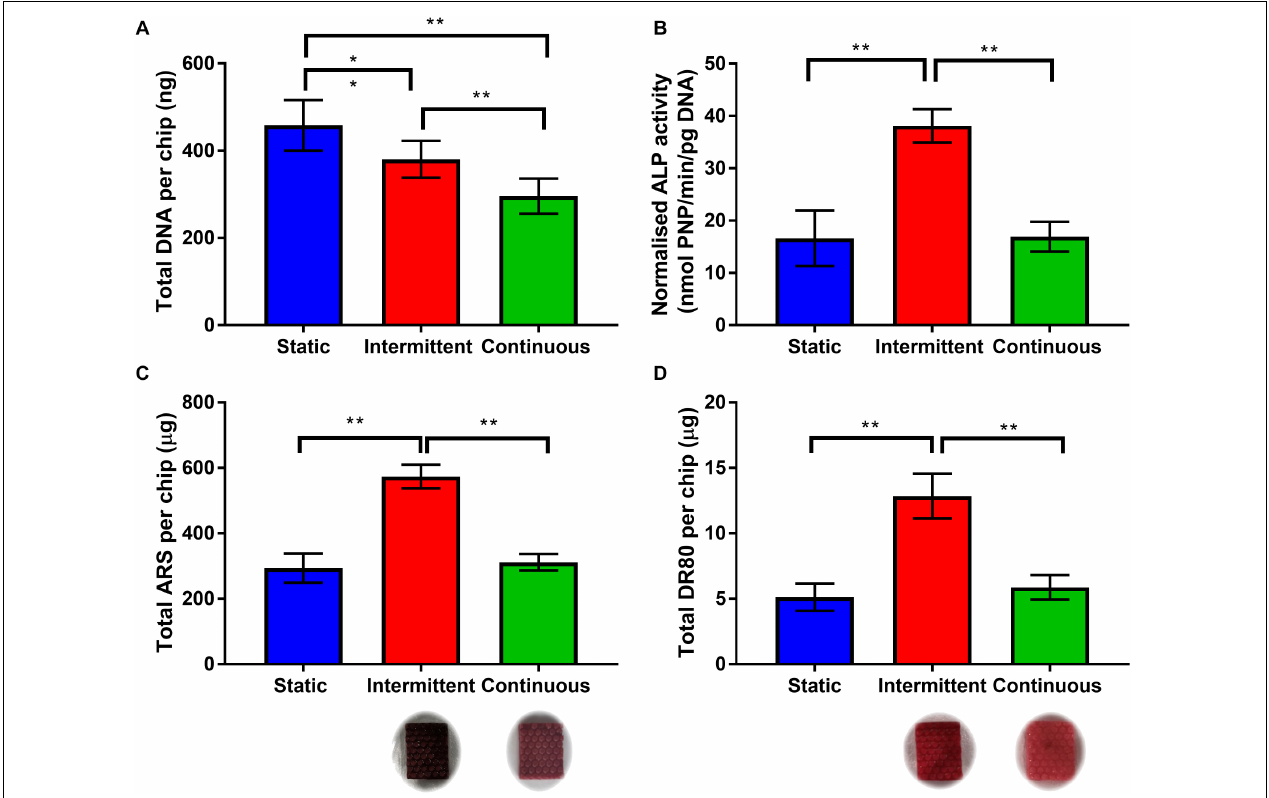
FIGURE 4 | (A) Total DNA per chip foreach flow profile on day 14. Both intermittent and continuous are significantly lower thanstatic, with continuous significantly lower than intermittent ( n = 8) ( ∗ p < 0 . 05, ∗∗ p < 0 . 01). (B) Day 14 ALP activity normalized to total DNA. The intermittent flow profile resulted in significantly higher normalized activity than the static control and continuous flow profile. There is no significant different between static and continuous. (C,D) Comparison of matrix deposition of hES-MPs in three different flow conditions at day 21 in OIM. (C) Total Alizarin Red S (ARS) staining per chip, calcium content is significantly higher for intermittent flow, there is no difference between static and continuous. (D) Total Direct Red 80 (DR80) staining per chip, collagen deposition is also significantly higher for intermittent flow, no difference between static and continuous. Representative images inserted below the intermittent and continuous flow conditions ( n = 8) (** p <